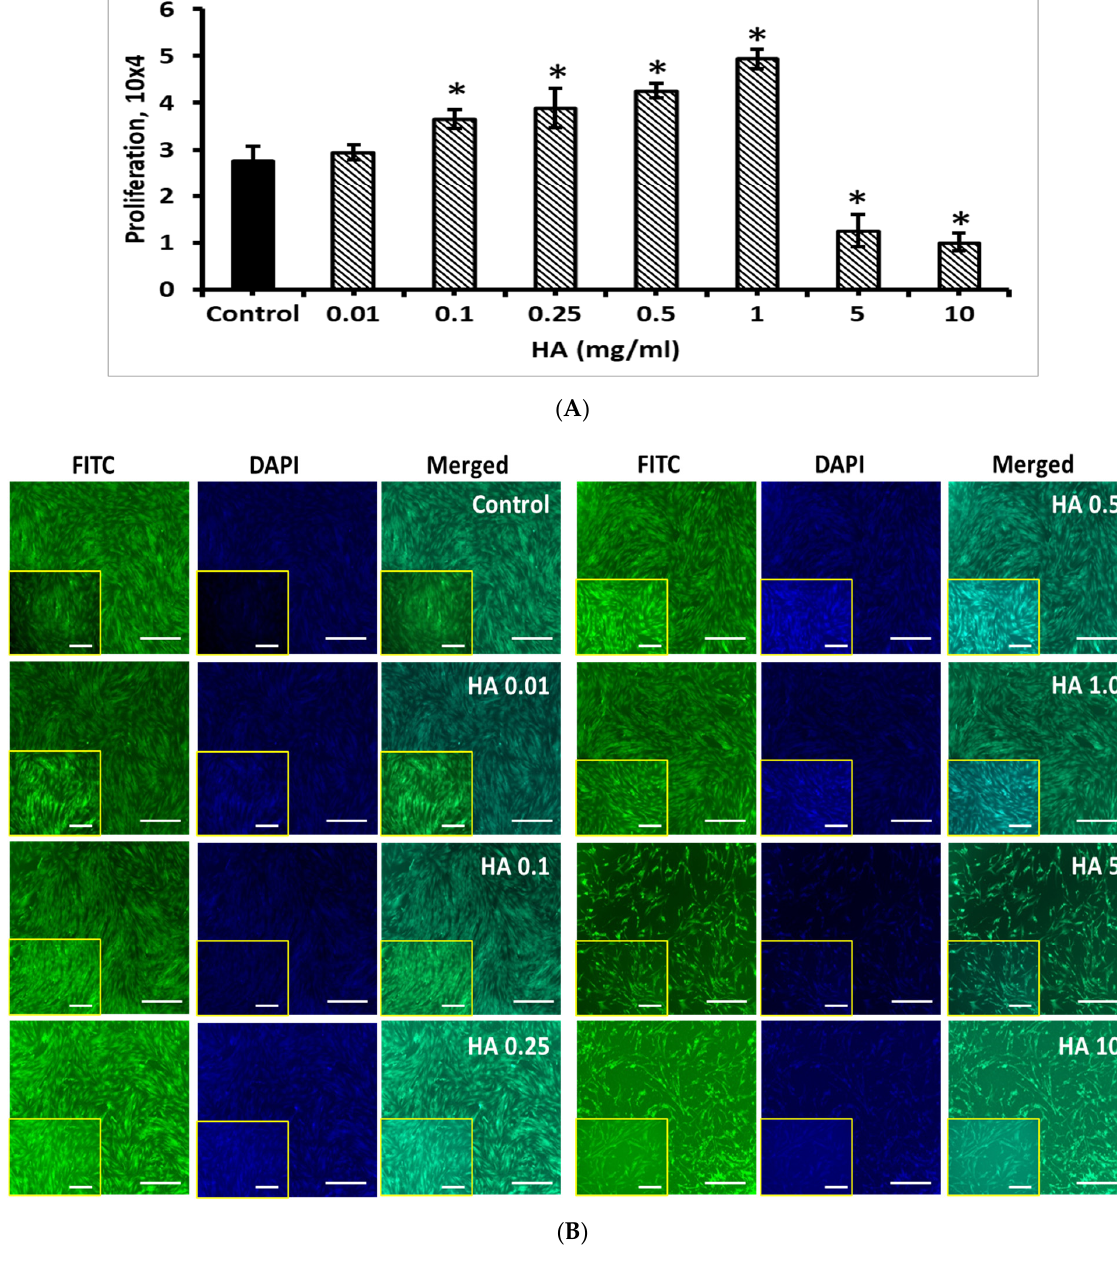
Figure 10. ( A ) Cell count and ( B ) Fluorescence (FITC, DAPI and merged) images of BM-MSCs cultured with HA. Control—BM-MSCs cultured without HA, HA 0.01, 0.1, 0.25, 0.5, 1.0, 5 and 10 represent their respective concentration of HA treated with BM-MSCs, respectively. Scale bar 5×-200 µm, 10×-100 µm (Insert). * denotes statistical significance, p < 0.05 vs. control